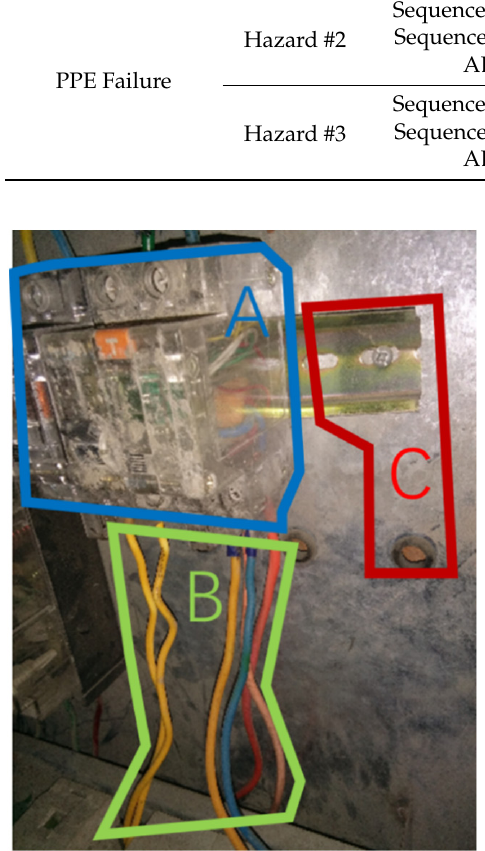
Figure 3. Potential electrical contact (Hazard #1).